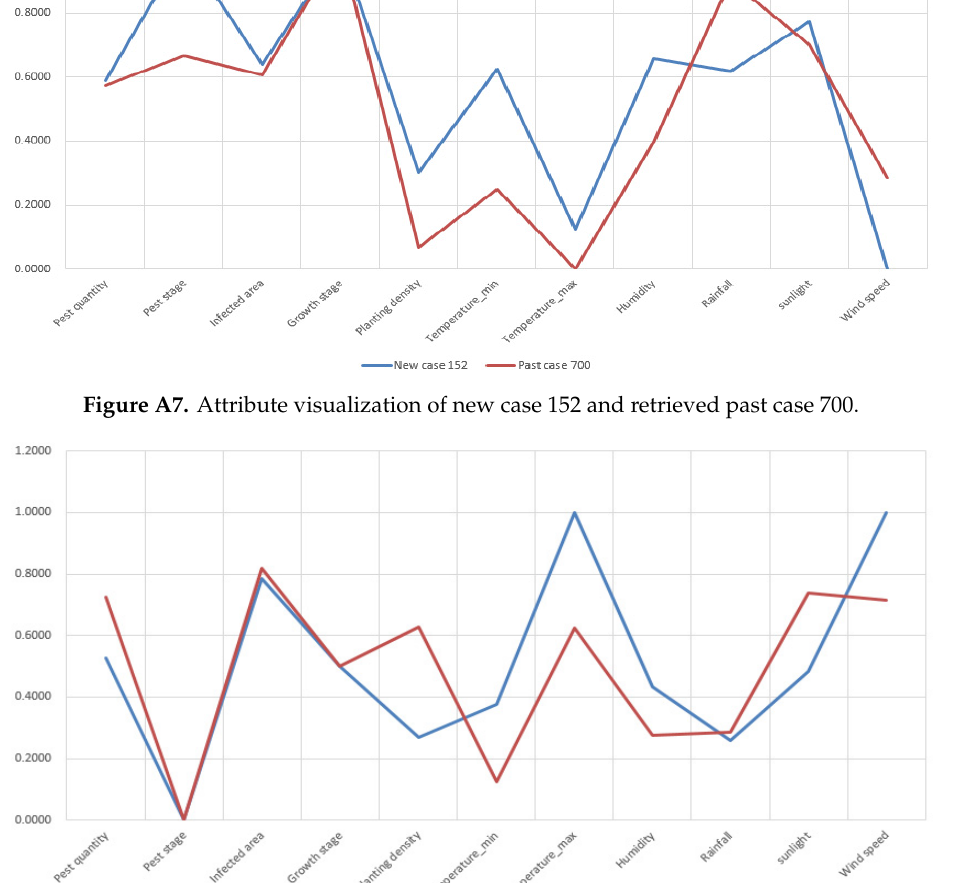
Figure A8. Attribute visualization of new case 153 and retrieved past case 918.